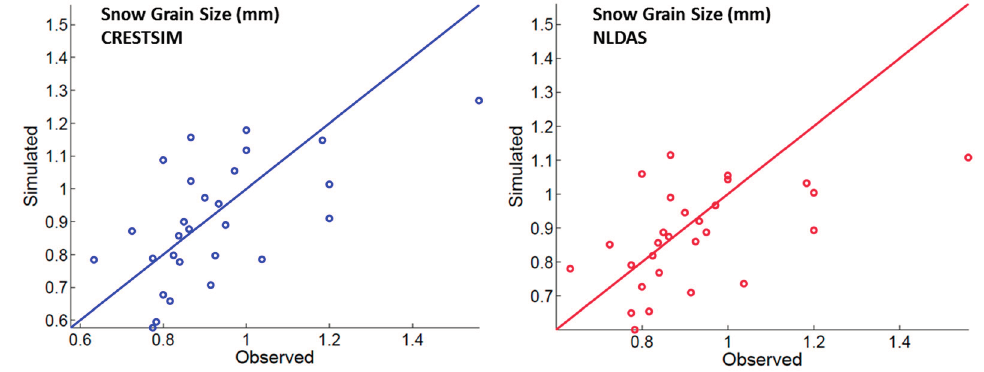
Figure 13. Time series for grain size (mm). Legend: NLDAS meteorological data simulation (NLDAS), CREST-SAFE meteorological data simulation (CRESTSIM), and manual CREST-SAFE observations (Observed).